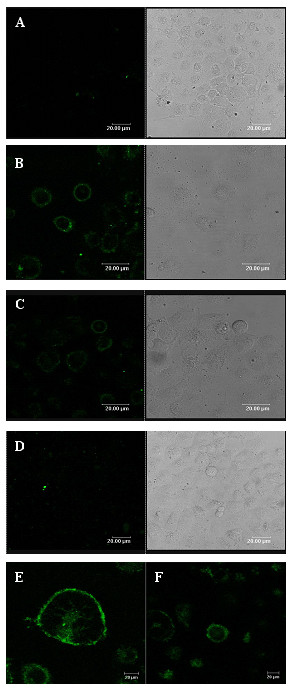
Confocal assay for the expression of Fas on the membrane of co-cultured Bel 7402 cells. Bel 7402 cells and Jurkat T cells were co-cultured with AFP (20 mg/L), anti-AFP antibody (40 mg/L), and AFP (20 mg/L) plus anti-AFP antibody (40 mg/L) respectively for 48 h. After removing Jurkat cells, Bel 7402 cells were incubated with rabbit anti-Fas antibody and secondary goat anti-rabbit IgG antibodies conjugated with FITC. The cells were observed using a confocal laser scanning microscope. Image A: separate-cultured Bel 7402 cell; B: separate-cultured Bel 7402 cells treated with AFP; C: co-cultured Bel 7402 cells treated with AFP; D: co-cultured Bel 7402 cells treated with anti-AFP antibody. Right images from A to D were taken under common microscope to observe the state of cells. E: co-cultured Bel 7402 cells; F: co-cultured Bel 7402 cells treated with AFP and anti-AFP antibody. All images were representative of an experiment that was repeated three times.